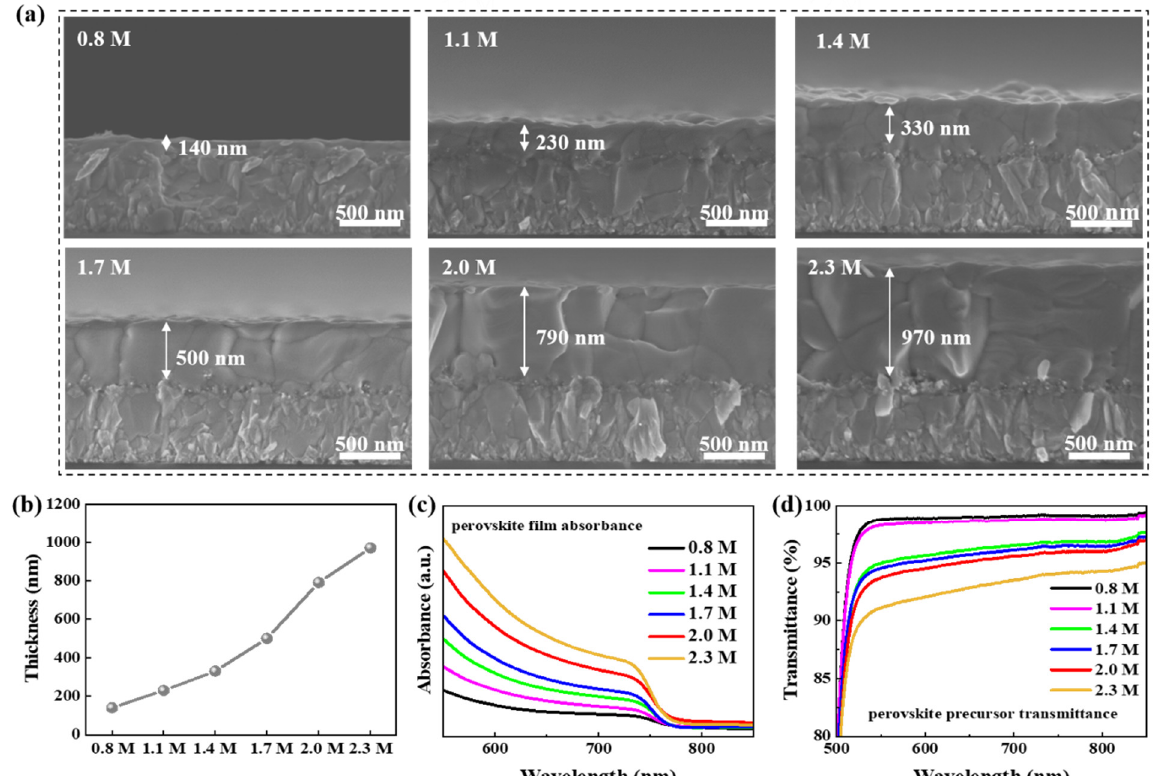
Figure 2. Absorption characteristics of perovskite films with different perovskite precursor concentration, 0.8 M, 1.1 M, 1.4 M, 1.7 M, 2.0 M, 2.3 M. ( a ) Cross-section SEM images, ( b ) Thickness of perovskite films, ( c ) Absorption spectra of perovskite films, ( d ) Transmittance spectra of perovskite solution.